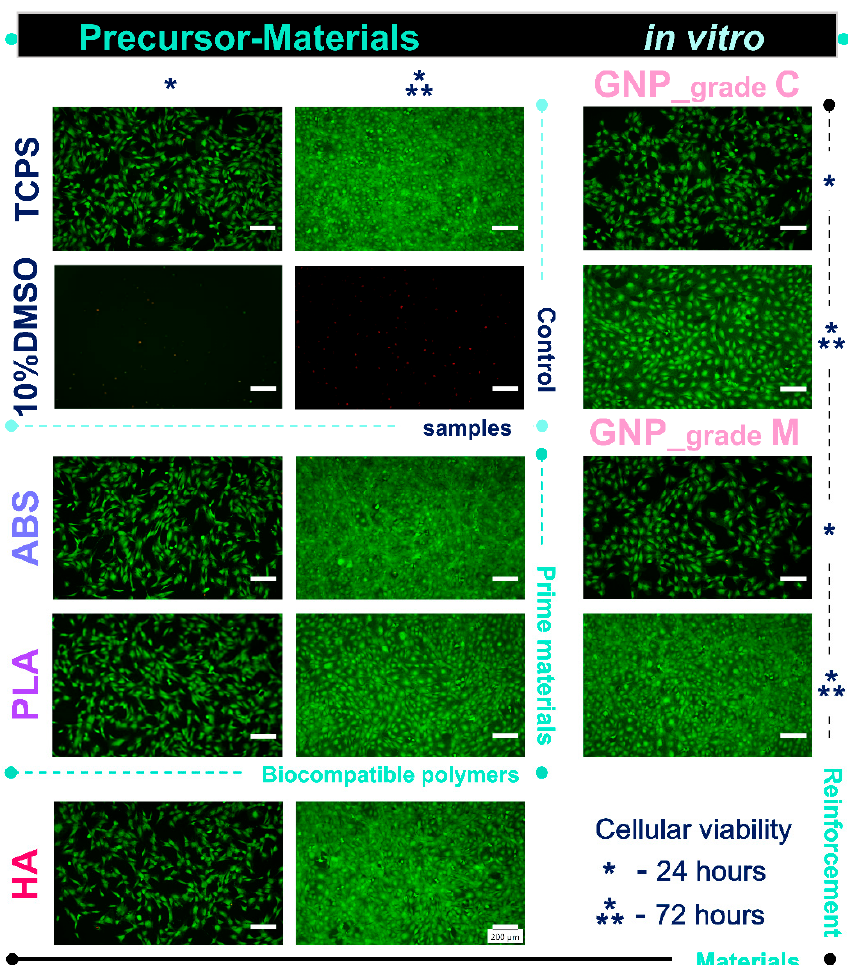
Figure 4. Fluorescence micrographs of the MC3T3-E1 pre-osteoblasts grown in the extraction media of precursor materials for 24 h and 72 h. The Live/Dead assay revealed the exclusive presence of green labelled viable cells in case of all analysed samples, except the positive cytotoxicity control where red fl uorescent dead cells were noticed. Scale bar: 200 µm.